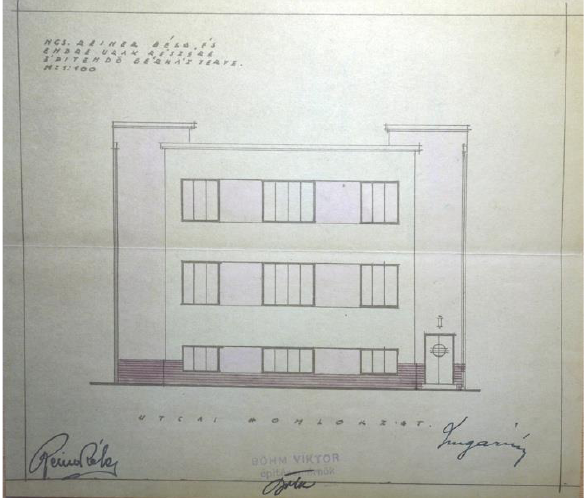
Figure 16. 12 Régiposta street. Original elevation drawing of the street façade. Architect: Victor